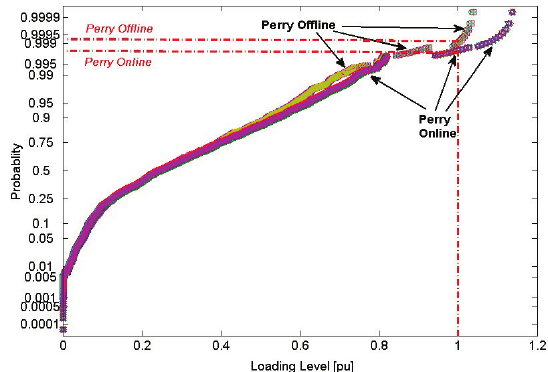
Figure 15. Distribution probability of loading levels in the FirstEnergy/PJM transmission